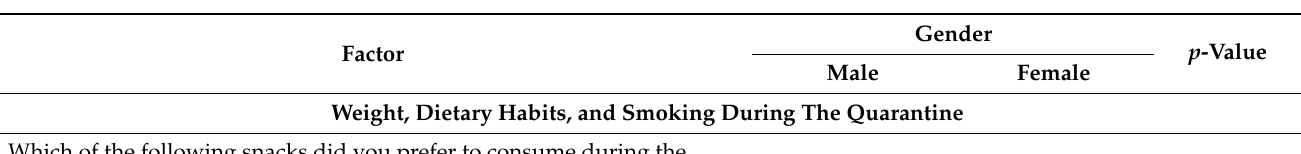
Table 6. Cont. Factor Weight, Dietary Habits, and Smoking During The